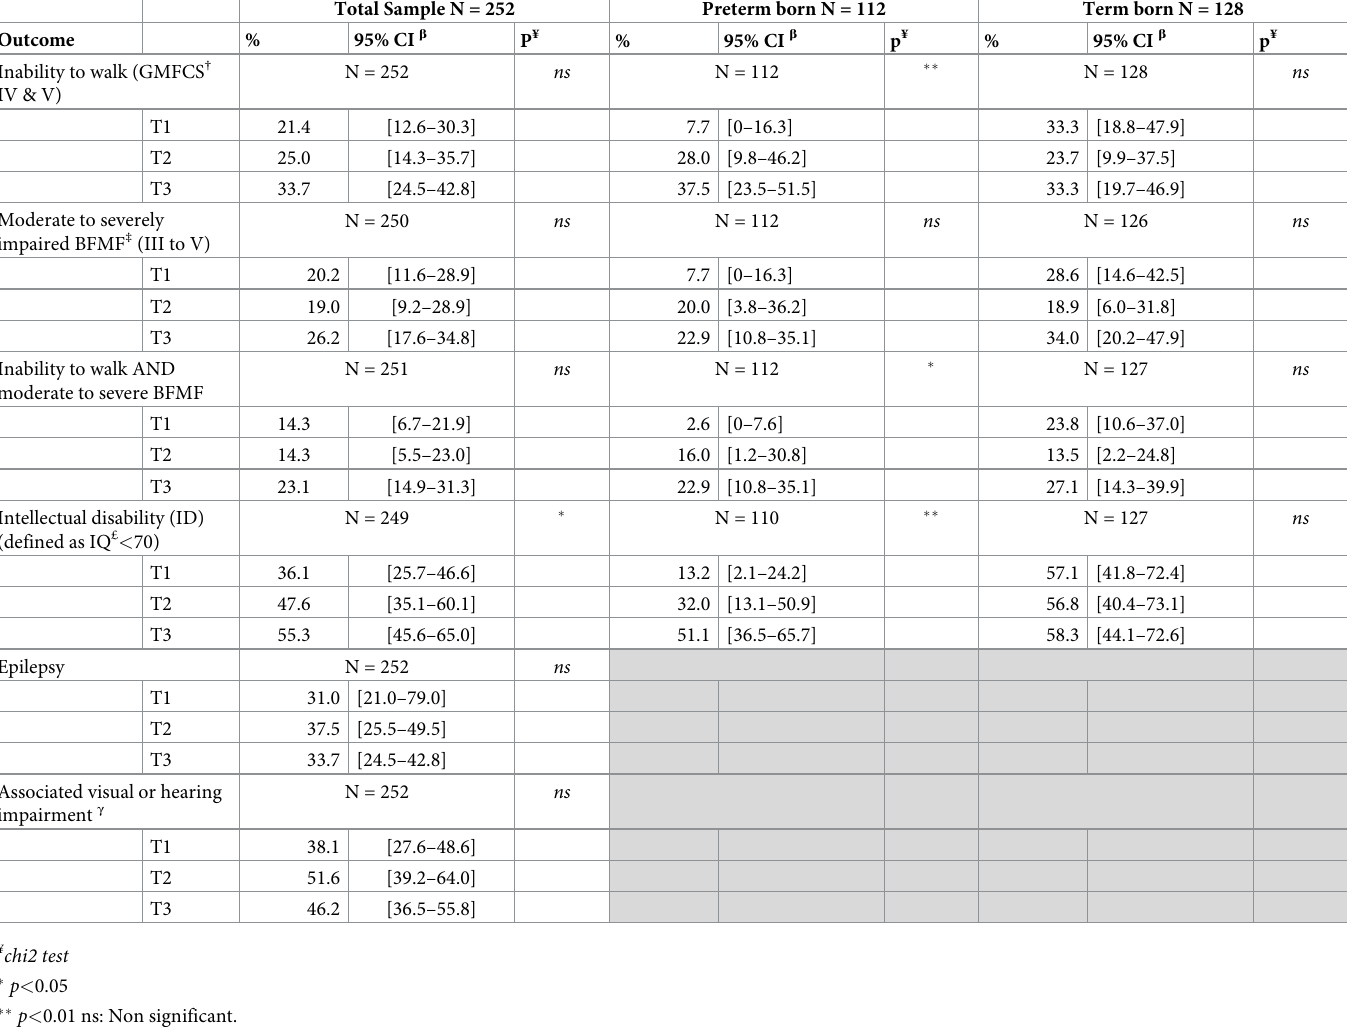
Table 4. Proportions of indicators of severity and associated disorders by European Deprivation Index (EDI) deprivation risk groups distribution tertiles after weighting for the number of 8-year-old children residing in each block, among term and preterm children with CP. The 1 st tertile (T1) corresponds to the least